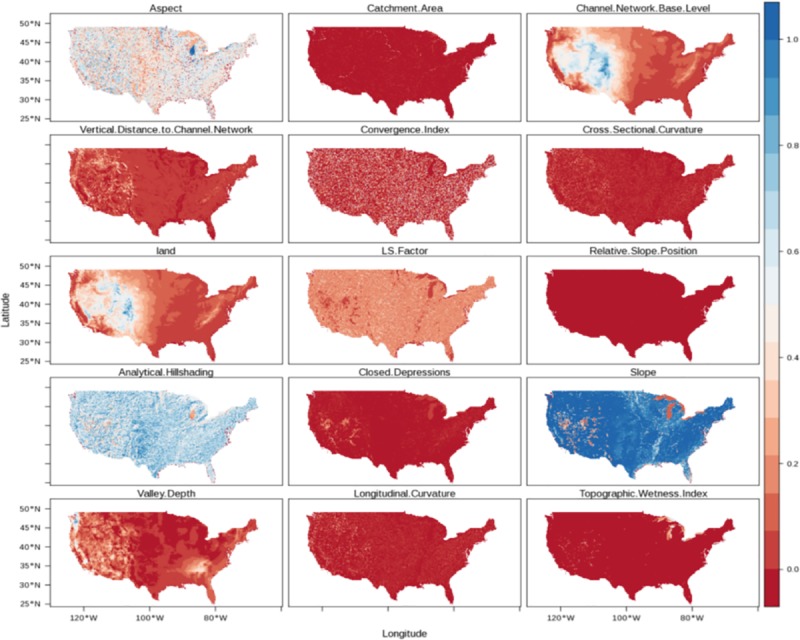
Elevation and hydrologically meaningful terrain parameters at 1x1km of spatial resolution derived using the standard SAGA-GIS basic terrain parameters module.These maps were normalized (between 0–1) and then used as prediction factors to downscale soil moisture across CONUS.